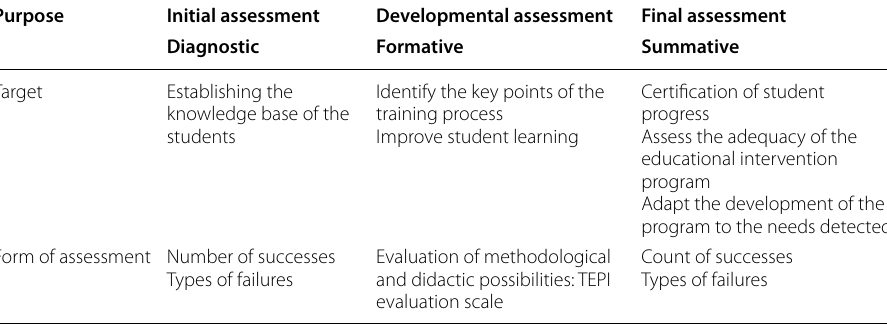
Table 1 Assessment of the intervention proposal